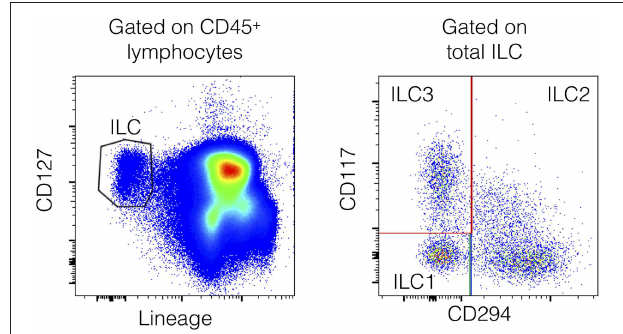
FIGURE 3 | Flow cytometry gating strategy for the identification of human peripheral blood ILCs. ILCs are defined as Lin − CD127 + cells with a lineage cocktail containing antibodies directed against CD3, CD19, CD14, TCR αβ , TCR γδ , CD94, CD16, Fc ε RI, CD34, CD123, and CD303 (Left) . Within the ILC gate, ILC2s are CD294 + cells, whereas ILC1s are CD294 − CD117 − cells and ILC3s are CD294 − CD117 + cells (Right)